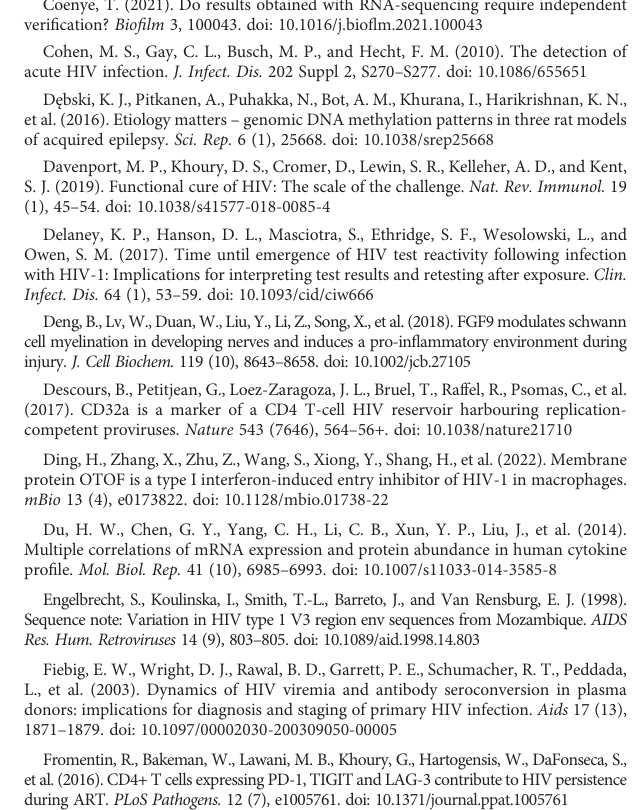
SUPPLEMENTARY TABLE 3 Effectof adjustmentforCD4+ Tcellcount(%) onTop50DEG.Pos. =Position ranked by adj.P.Val; HGNC = HUGO Gene Nomenclature Committee name of the gene; logFC = Log2 fold change; AveExpr = average expression across all samples, in log2 counts per million reads; adj.P.Val = Benjamini- Hochberg false discovery rate adjusted p-value; no-adj pos. = comparative position in the previous table, without adjustment for CD4+ T cell count (%). Yellow = top 50 DEG concordant in both analyses; orange = top 50 DEG discordant between analyses (though all within top 100). SUPPLEMENTARY TABLE 4 Full list of differentially expressed gene sets – acute HIV cases versus HIV negative controls as determined by gene set enrichment analysis (GSEA). (A) Overexpressed gene sets. (B) Underexpressed gene sets. # = Rank by NES; Name = Gene Ontology name of the geneset; Size = the number of genes in the geneset; NES = Normalized Enrichment Score; NOM p-val = nominal P value (statistical signi fi cance of the observed ES relative to null distribution); FDR q-val = False Discovery Rate Q value (the P value has been adjusted for FDR). SUPPLEMENTARY TABLE 5 Intracellular gene expression changes correlated moderately with measured SUPPLEMENTARY FIGURE 1 Mean mapped reads of three case samples as sequenced on two different RNAseq batches. SUPPLEMENTARY FIGURE 2 Top 20 most up and down-regulated gene sets, associated with adjustment for cell